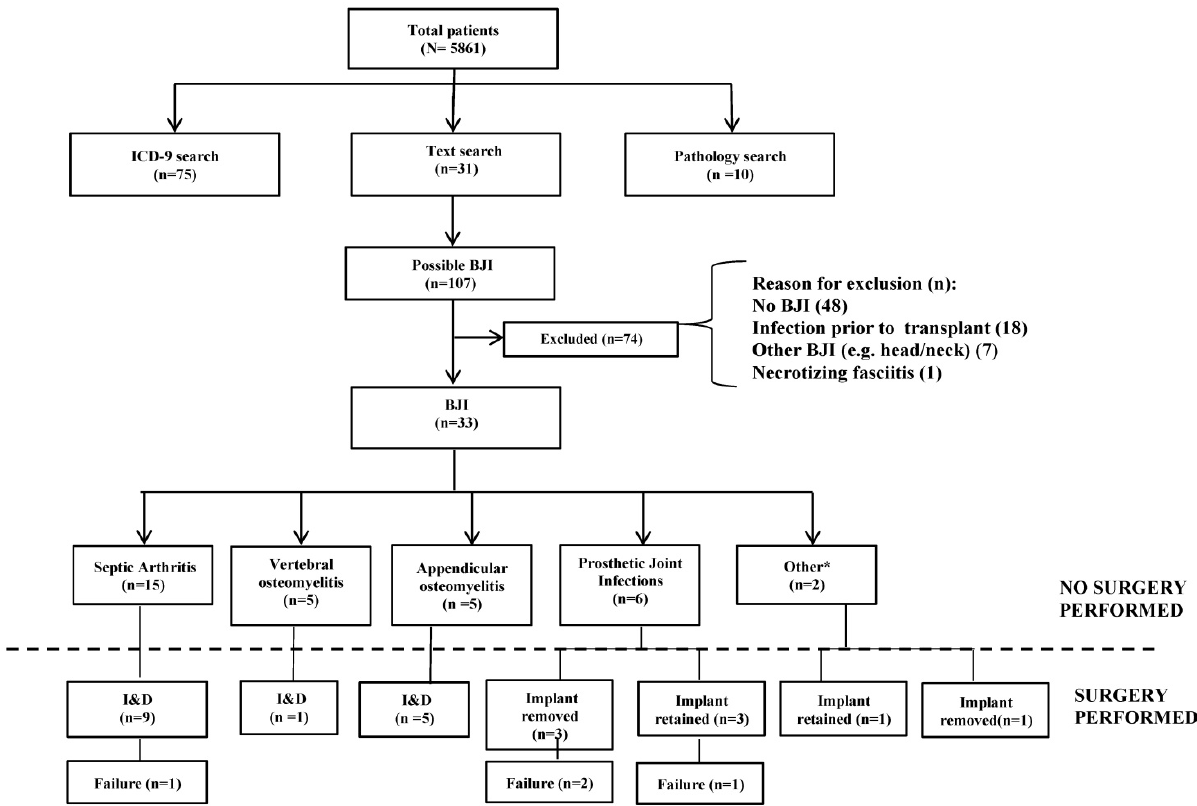
Figure 1: Flowchart of the Transplant study cohort. LEGEND: HSCT = Hematopoietic stem cell transplant BJI = Bone and Joint Infection *Other –orthopedic implant infection.